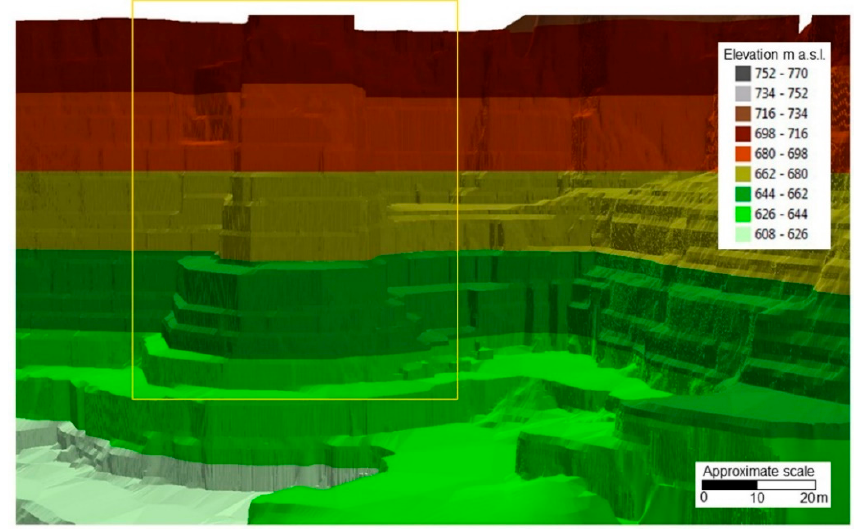
Figure 9. Three-dimensional representation of the elevation through a TIN (Triangulated Irregular Network) model. The yellow rectangle highlights the marble buttress area.